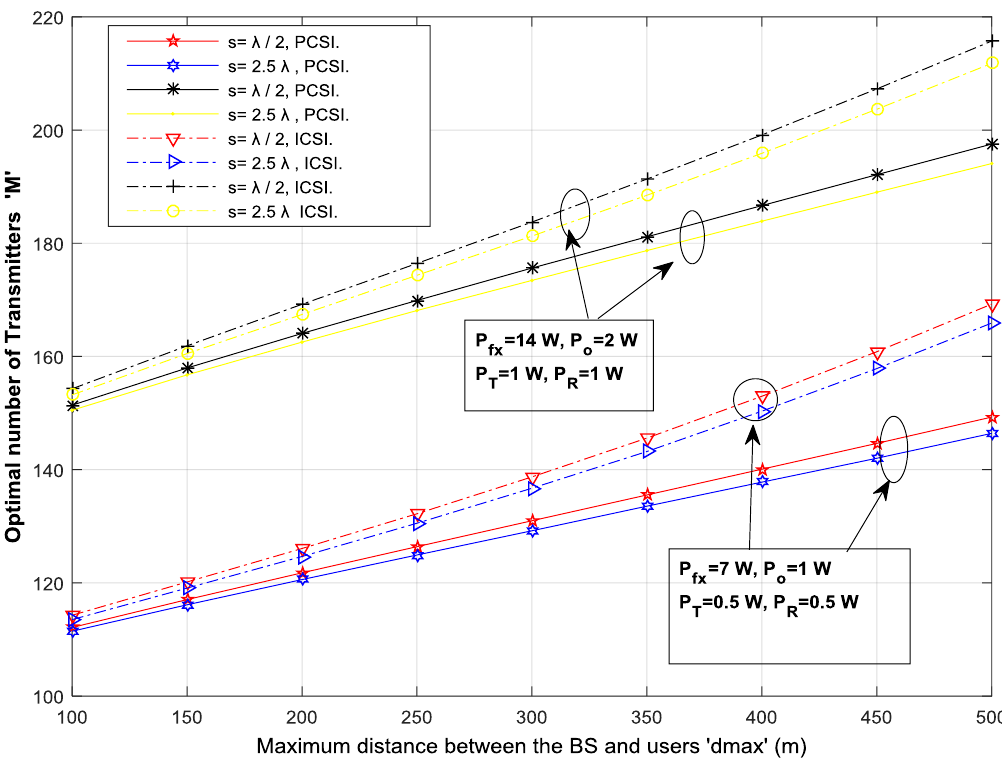
Figure 6. Number of optimal Transmitters.